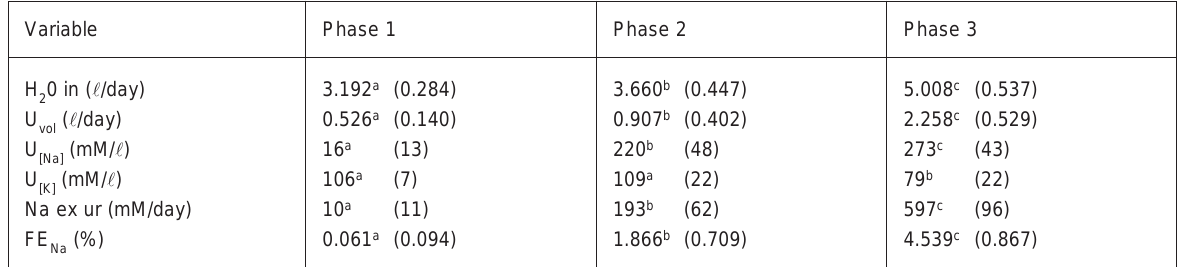
TABLE 1 Daily drinking water intake (H centration